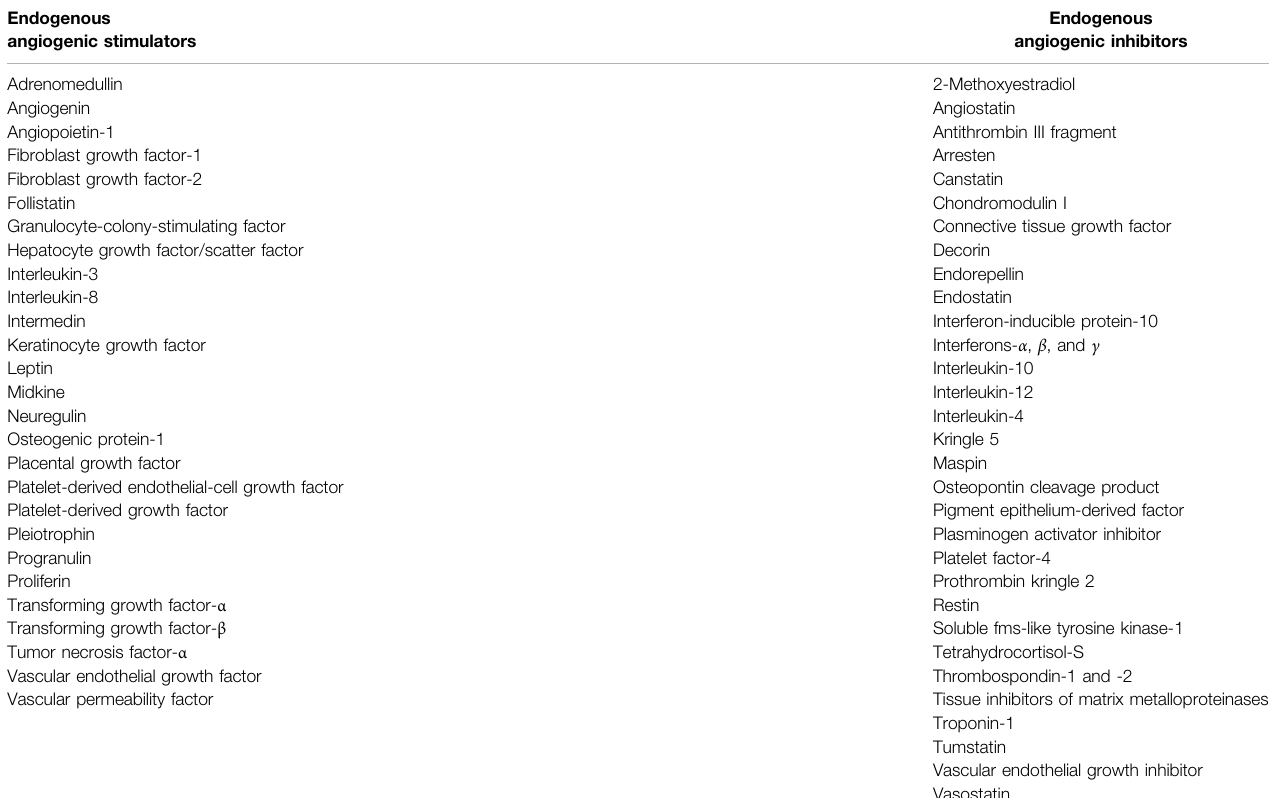
TABLE 1 | List of endogenous angiogenic stimulators and